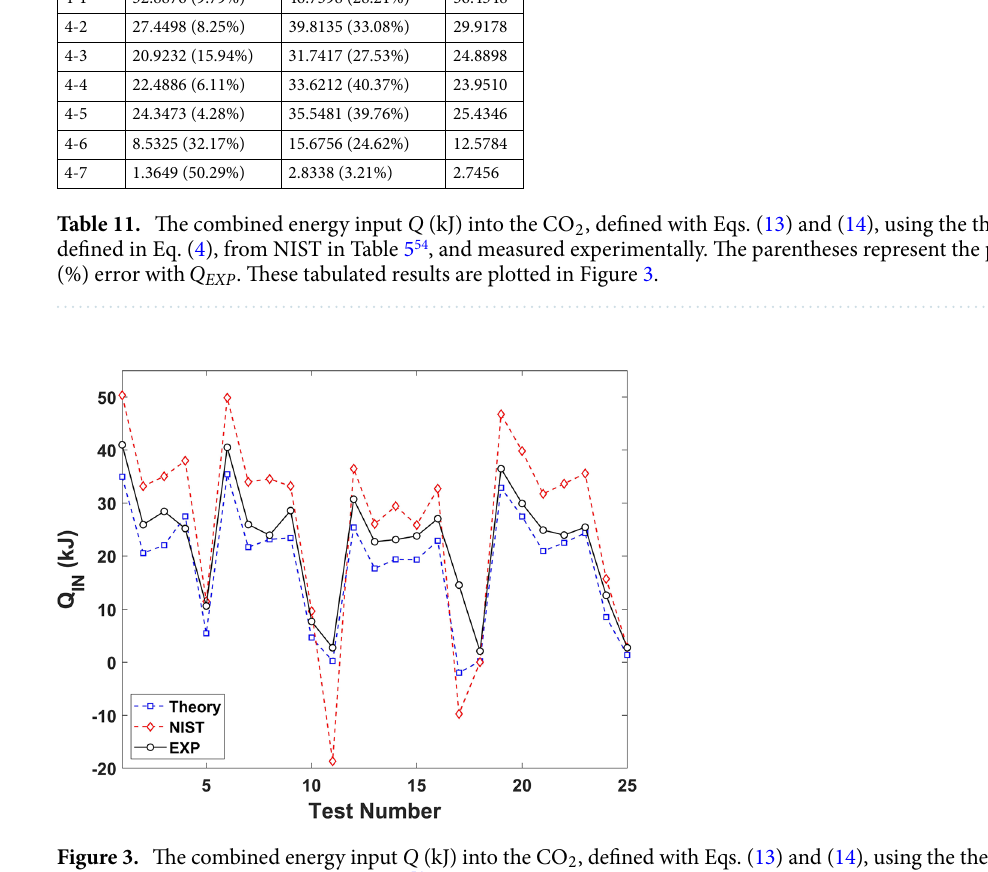
Figure 3. The combined energy input Q (kJ) into the CO 2 , defined with Eqs. (13) and (14), using the theory defined in Eq. (4), from NIST in Table 5 54 , and measured experimentally. These plotted results are tabulated